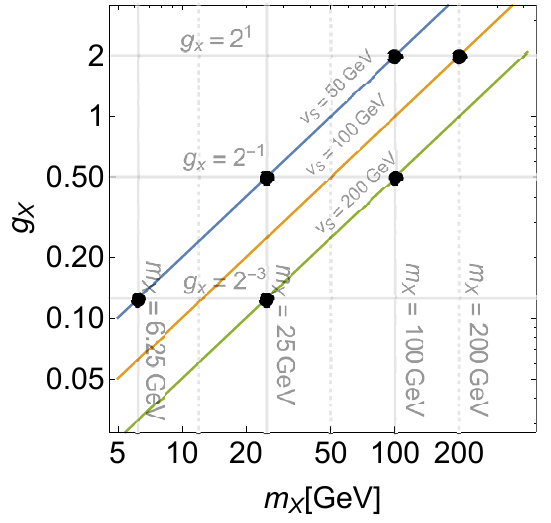
Figure 2 . The six benchmark points are blobbed on the ( m X , g X )-plane. The solid lines show the cases of v S [GeV] = 50 (blue), 100 (orange), 200 (green) from the top. while those from the bubble wall collision and the turbulence are not significant [132, 133]. We employ the approximate analytic formula provided in ref. [85] for computing the spectrum of the